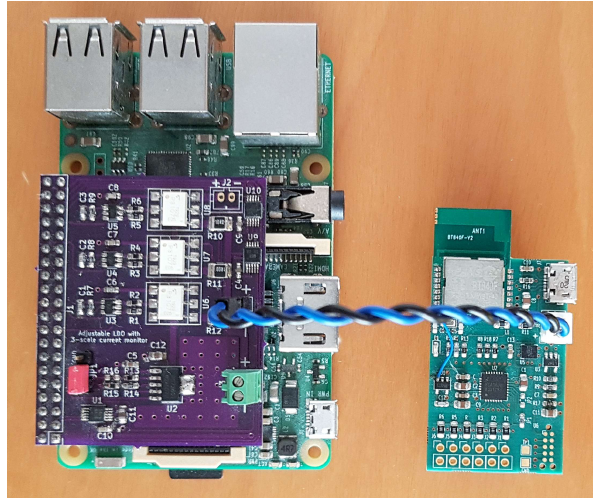
Figure 8. Photograph of the whole system, showing the custom-made source-meter unit (purple board attached on top of the Raspberry Pi, left) powering the EMG wireless sensor board (right) through its battery connector.